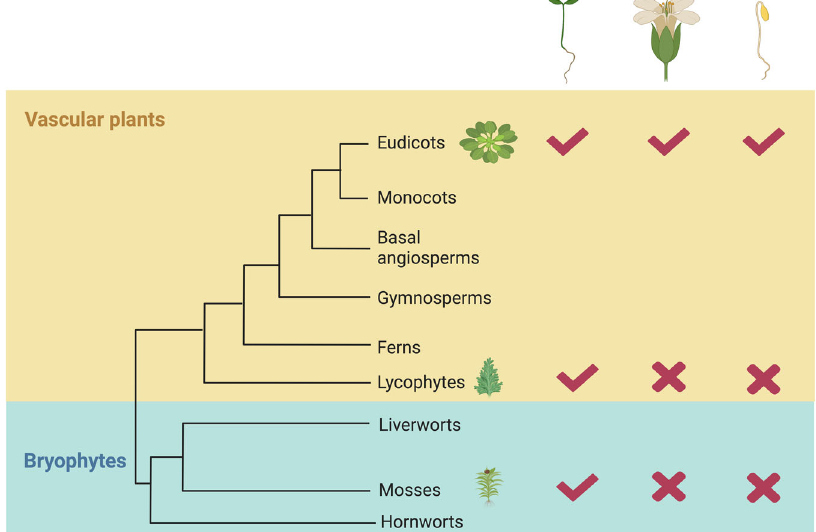
Fig. 9 Functional divergence of HLS1 in plants. According to the most up-to-date plant evolutionary relationships 39 and our results, we demonstrated that the functions of HLS1 in the regulation of thermomorphogenesis (elongated seedling cartoon) were conserved from bryophytes to eudicots (shown as check marks). However, the HLS1 orthologs in lycophyte or mosses could not function in fl owering time control ( fl ower cartoon) and hook development (depicted as wrong marks). The cartoon was created with